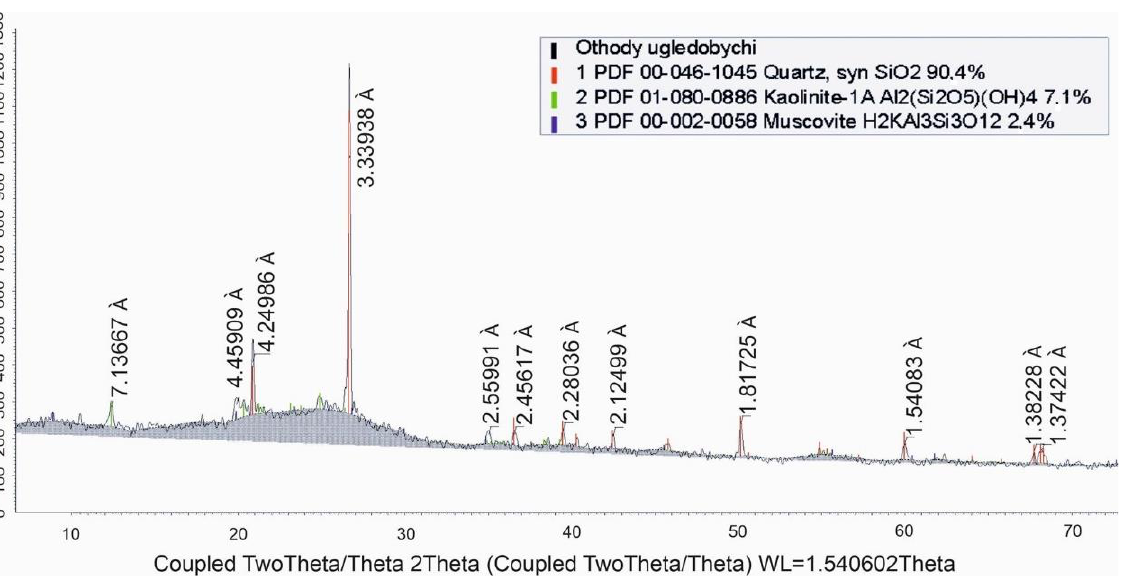
Figure 3. X-ray diffraction analysis of coal mining waste. According to the data shown in the figure, the structure of coal mining waste wascharacterized by minerals such as quartz, kaolinite and muscovite. It was found that a significant part of the structure wasoccupied by quartz-type minerals (90.4%). Moreo- ver, compounds in the form of kaolinite and muscovite hadfractions of 7.1% and 2.4%,